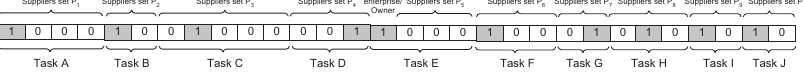
Curve 1: AGA individual optimal fitness value curve Curve 2: AGA individual average fitness value curve Curve 3: PSO individual average fitness value curve Curve 4: SGA individual average fitness value curve